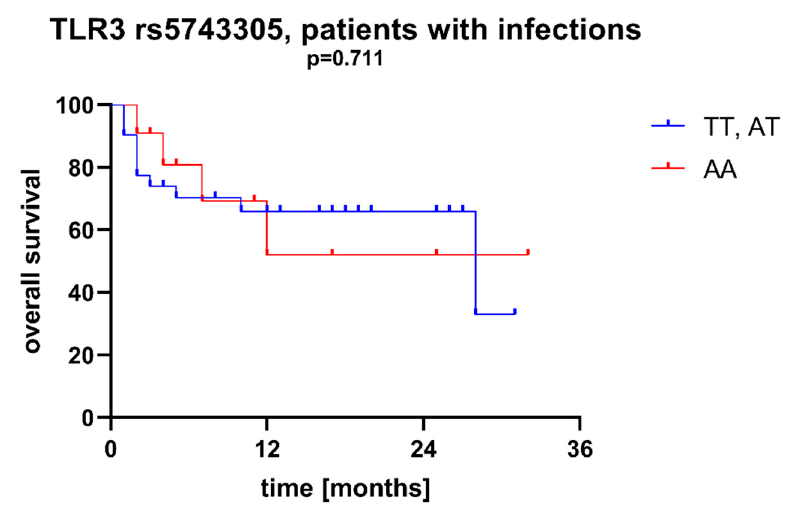
Figure 5. Overall survival of patients with different SNPs in TLR3 rs5743305—patients with infections during AML therapy.